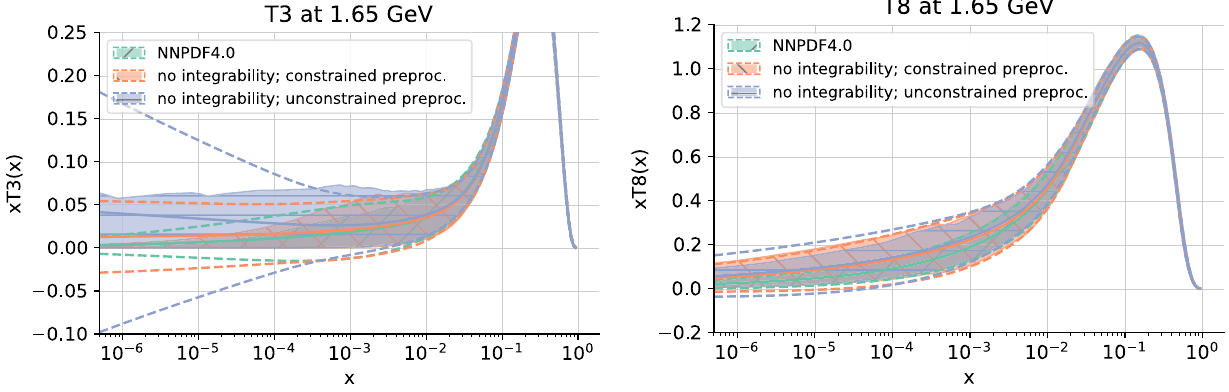
Fig. 48 Comparison to the baseline of PDFs obtained removing either or both the new integrability constraints on the triplet and octet PDFs (see text). The triplet T 3 and octet T 8 are shown at Q = 1 . 65